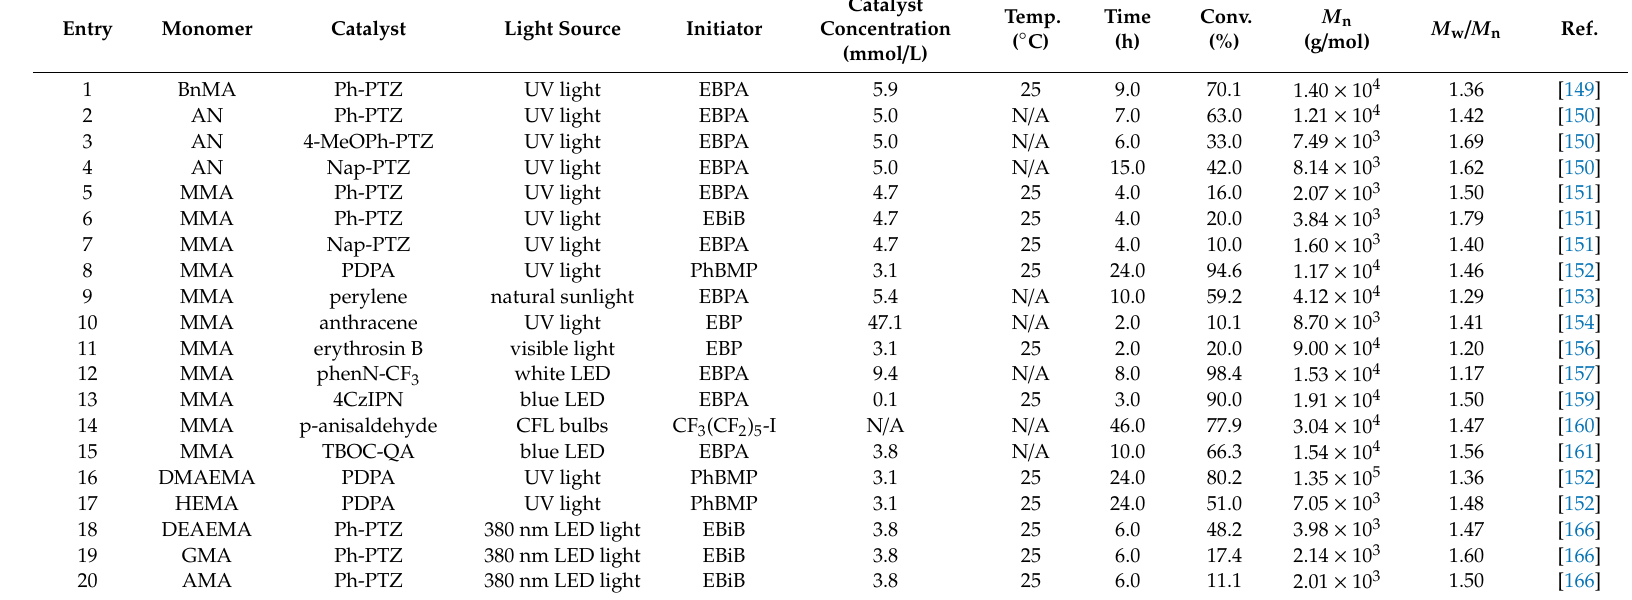
Table 3. Metal-free catalyst mediated